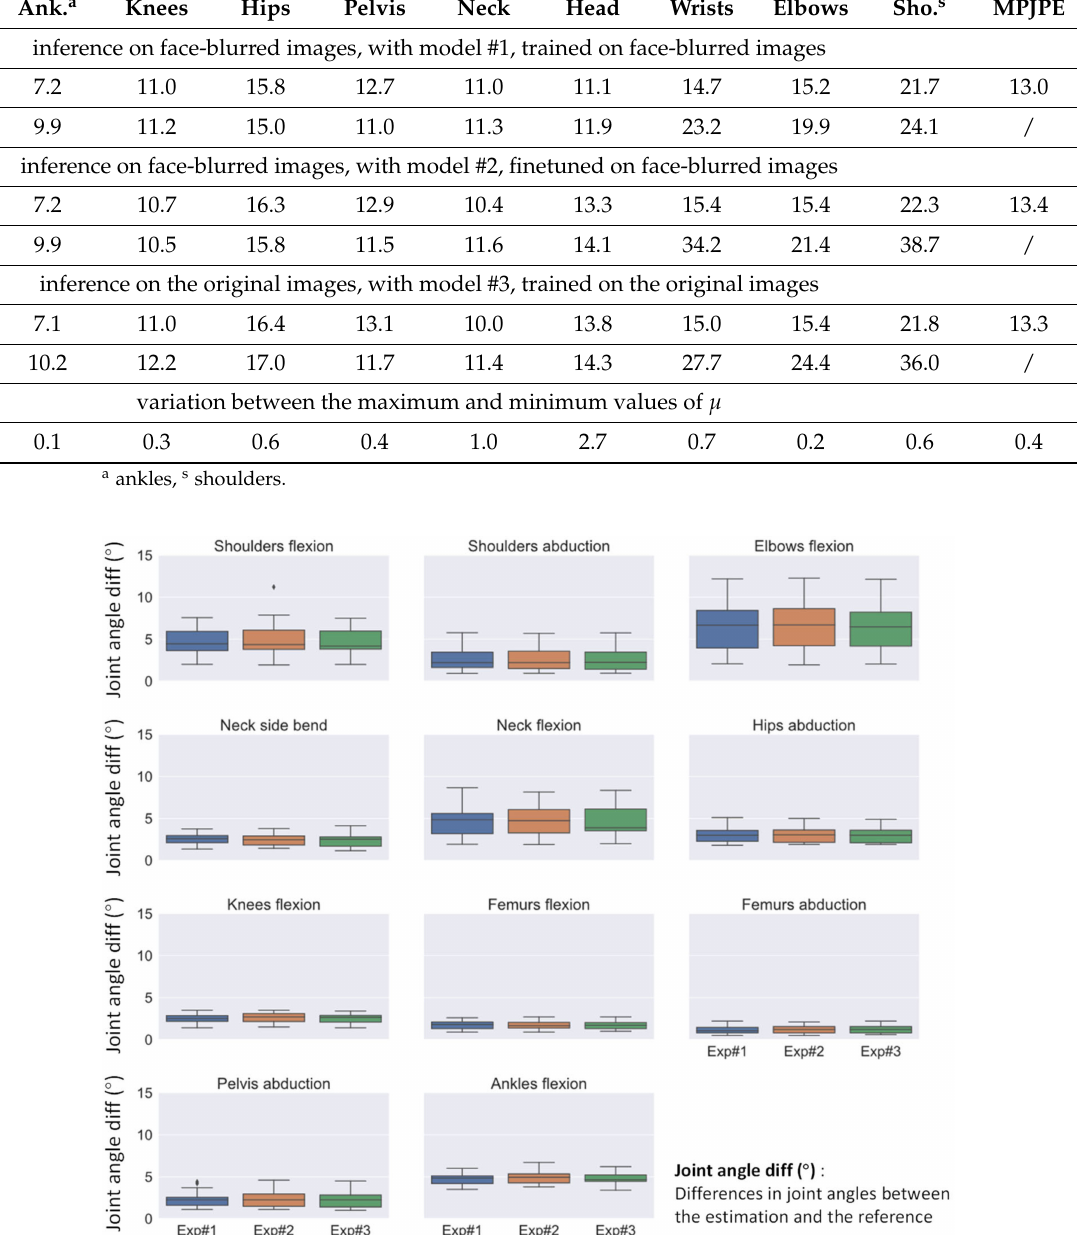
Figure 5. Box plots of the distribution of joint angle differences (RMSEs of the frames for each subject in the